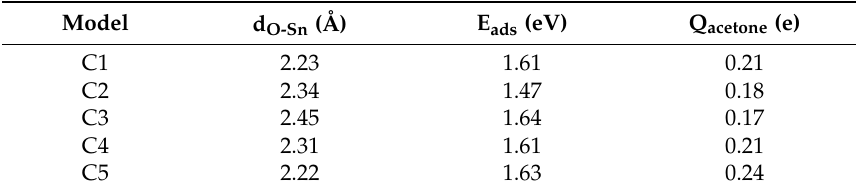
Figure 13. The optimized geometry of a 2 × 4 SnO 2 (110) stoichiometric surface and the adsorption configuration of the acetone molecule on the surface. Table 3. The calculated results of different configurations: d O-Sn is the O acetone -Sn bond length; E ads is the adsorption energy; Q acetone is the net charge transfer from acetone molecule to SnO 2 surface.